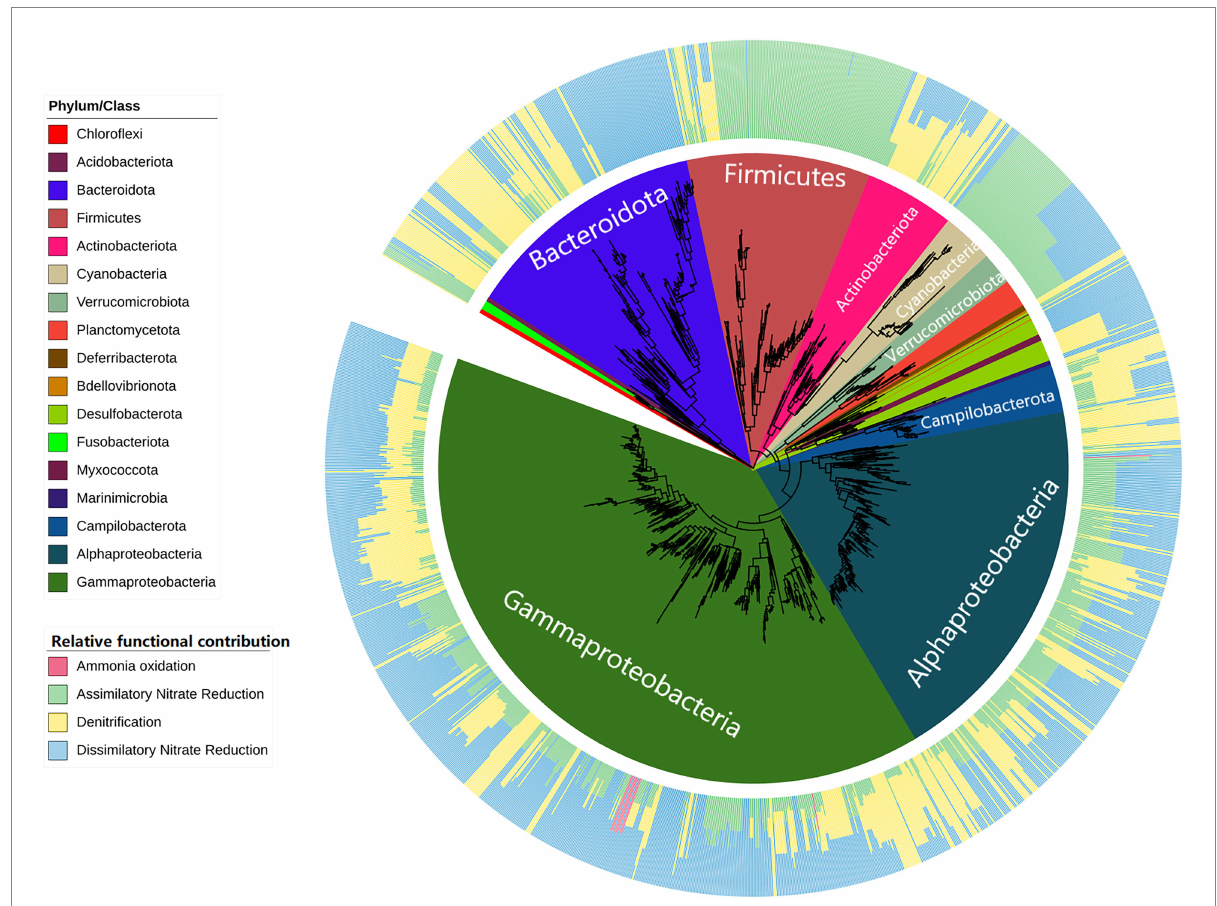
FIGURE 9 Phylogenetic tree of nitrogen cycle-related bacteria predicted by PICRUSt2 in Hong Kong coastal waters. The inner circle plot indicates corresponding phylum, or class taxonomy for phylum Proteobacteria, of the phylogenetic tree. The outer circle plot indicates the proportion of nitrogen cycle-related functional abundance assigned to individual nitrogen cycling pathways within the